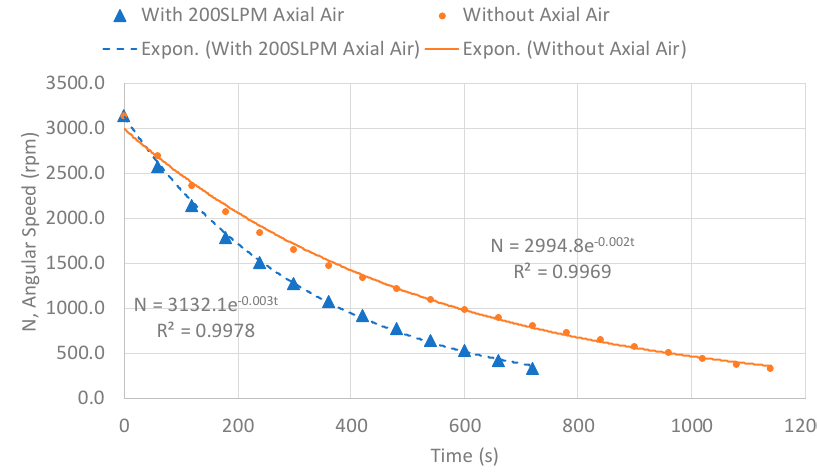
Figure 8. Speed versus time rotor spin down test results.